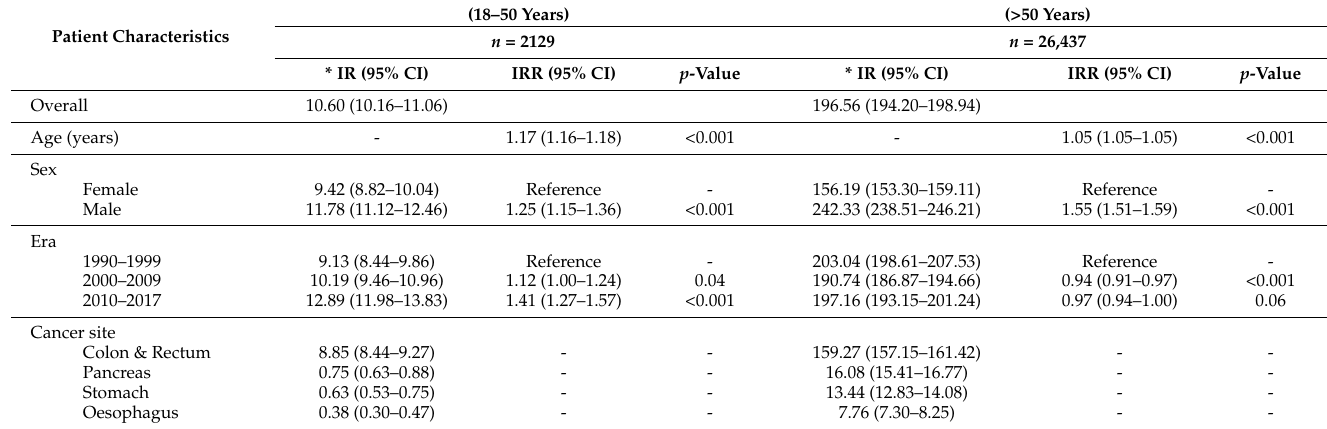
Table 2. Incidence rates (IR) and incidence rate ratios (IRR) for age, sex, era, and cancer sites between two age groups ( n =